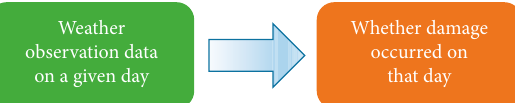
Figure 10: Algorithm 1 concept.